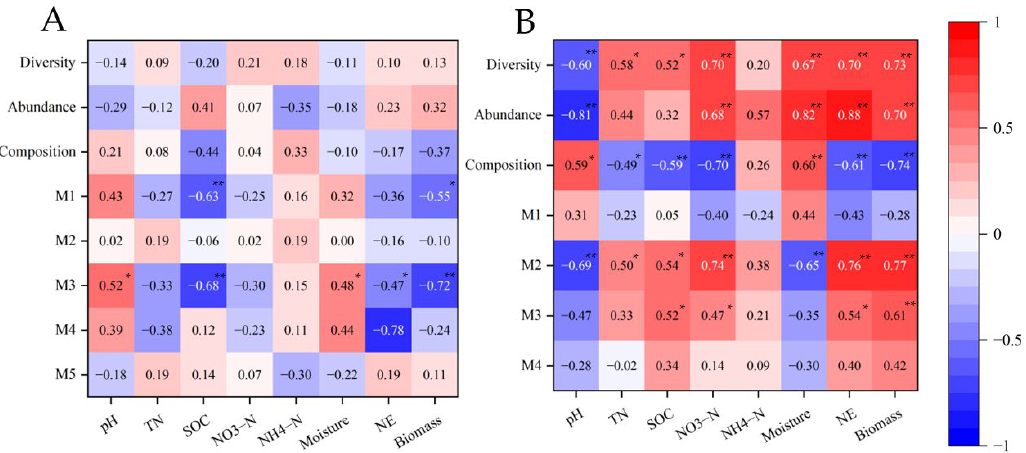
Figure 8. A and B represent the AOA and AOB respectively. Correlation analysis of microbial indicators on physicochemical properties of soil and N 2 O emissions and above-ground biomass. Red color represents positive correlations and blue represents negative correlations. The asterisk symbol represents statistical significance, where * stands for p < 0.05 and ** stands for p < 0.01. Abbreviations: total nitrogen (TN); soil water content (WC); soil organic carbon (SOC); nitrate nitrogen (NO 3 − N); ammonia nitrogen (NH 4 − N); N 2 O emission